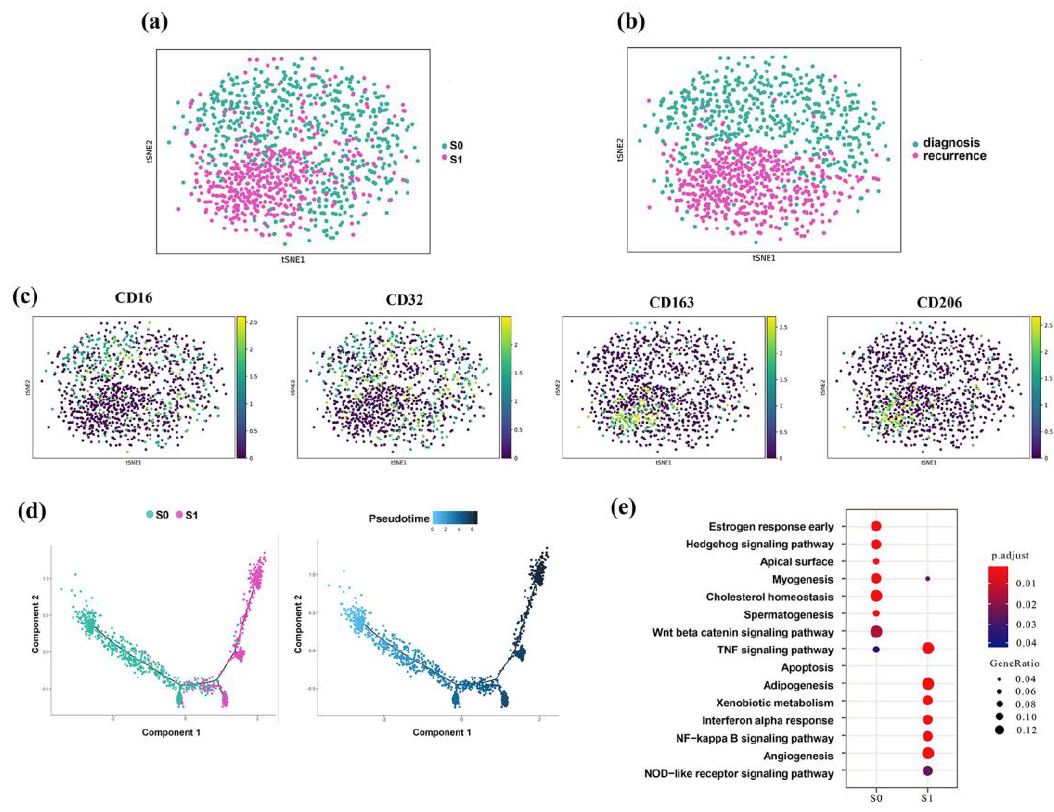
Figure 4. Infiltration of M2 macrophages in EOC progression. ( a , b ) T-SNE map of subcluster analysis for macrophages, colored by cell types ( a ) and sample groups ( b ). ( c ) Canonical markers for the M1 macrophage and M2 macrophage. ( d ) Pseudotime graph of two subgroups of macrophages in- ferred by Monocle 2. ( e ) Differential activated pathways among the two subgroups of macrophages.